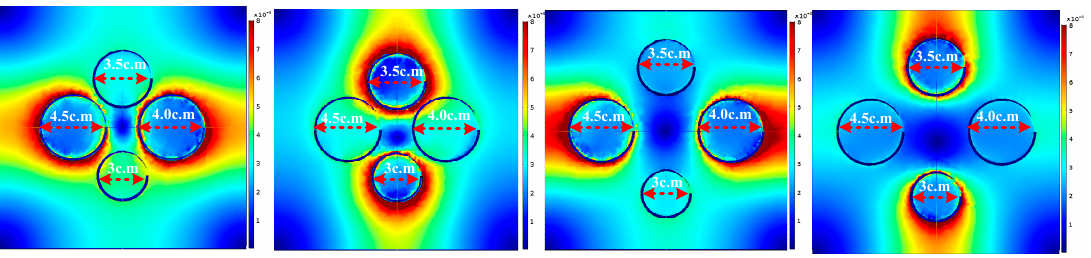
Figure 12. Magnetic field intensity of two identical frequency Rx with compensation.